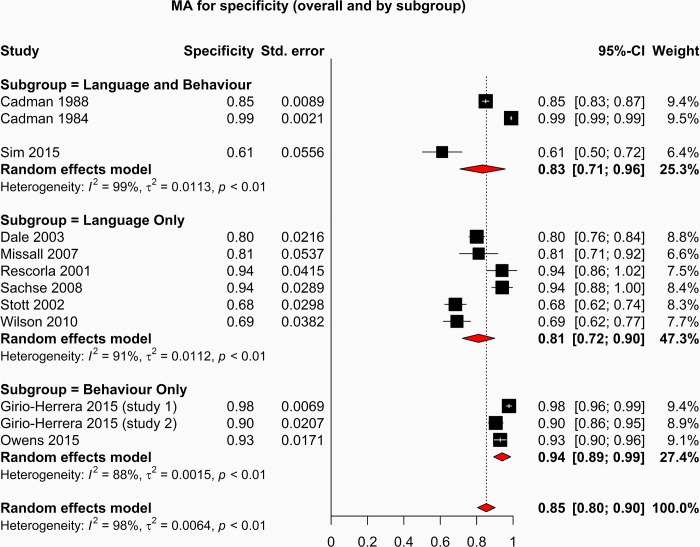
Specificity forest plot.